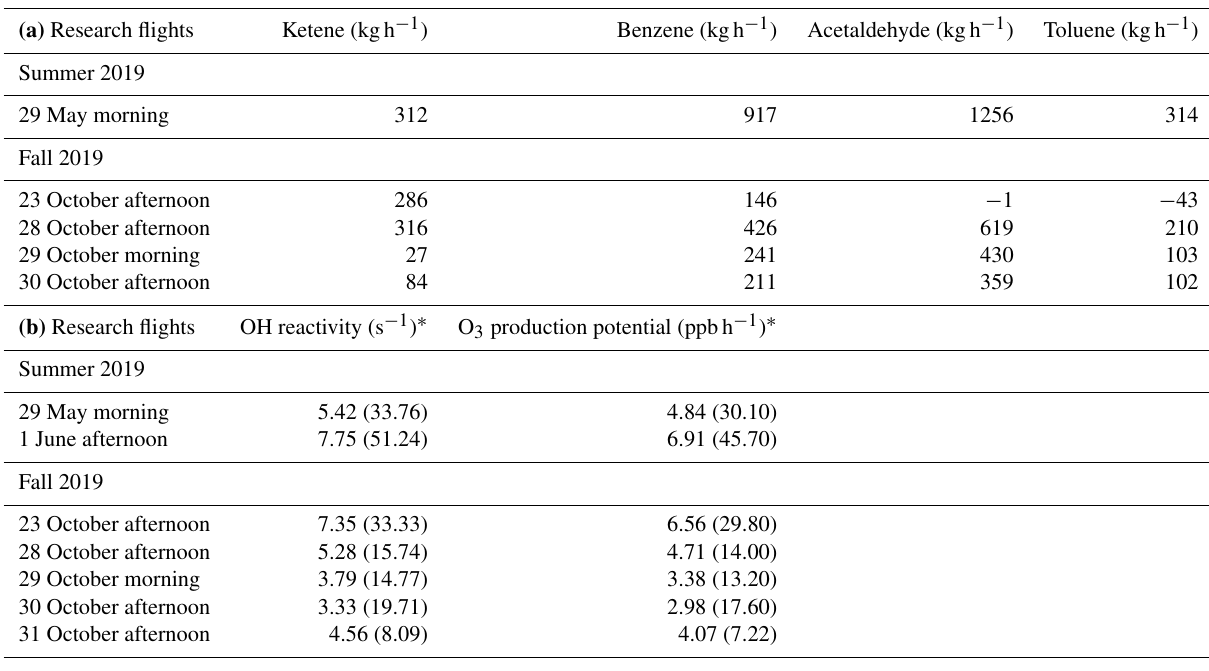
Figure 3. Kriging interpolated ketene mixing ratios for the (a) 29 May morning flight and (b) 28 October afternoon flight. Black dots represent the flight path. Table 2. (a) Net emission rates (kgh − 1 ) of ketene, benzene, acetaldehyde, and toluene over Daesan petrochemical facility. (b) Calculated average OH reactivity (s − 1 ) and O 3 production potential (ppbh − 1 ) of ketene during emission plumes measured over Daesan petrochemical